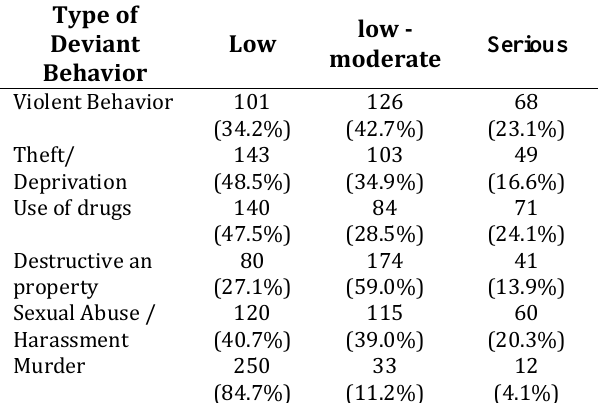
Table 3. Overview of Juvenile Delinquency Based on the Type of Deviant Behavior